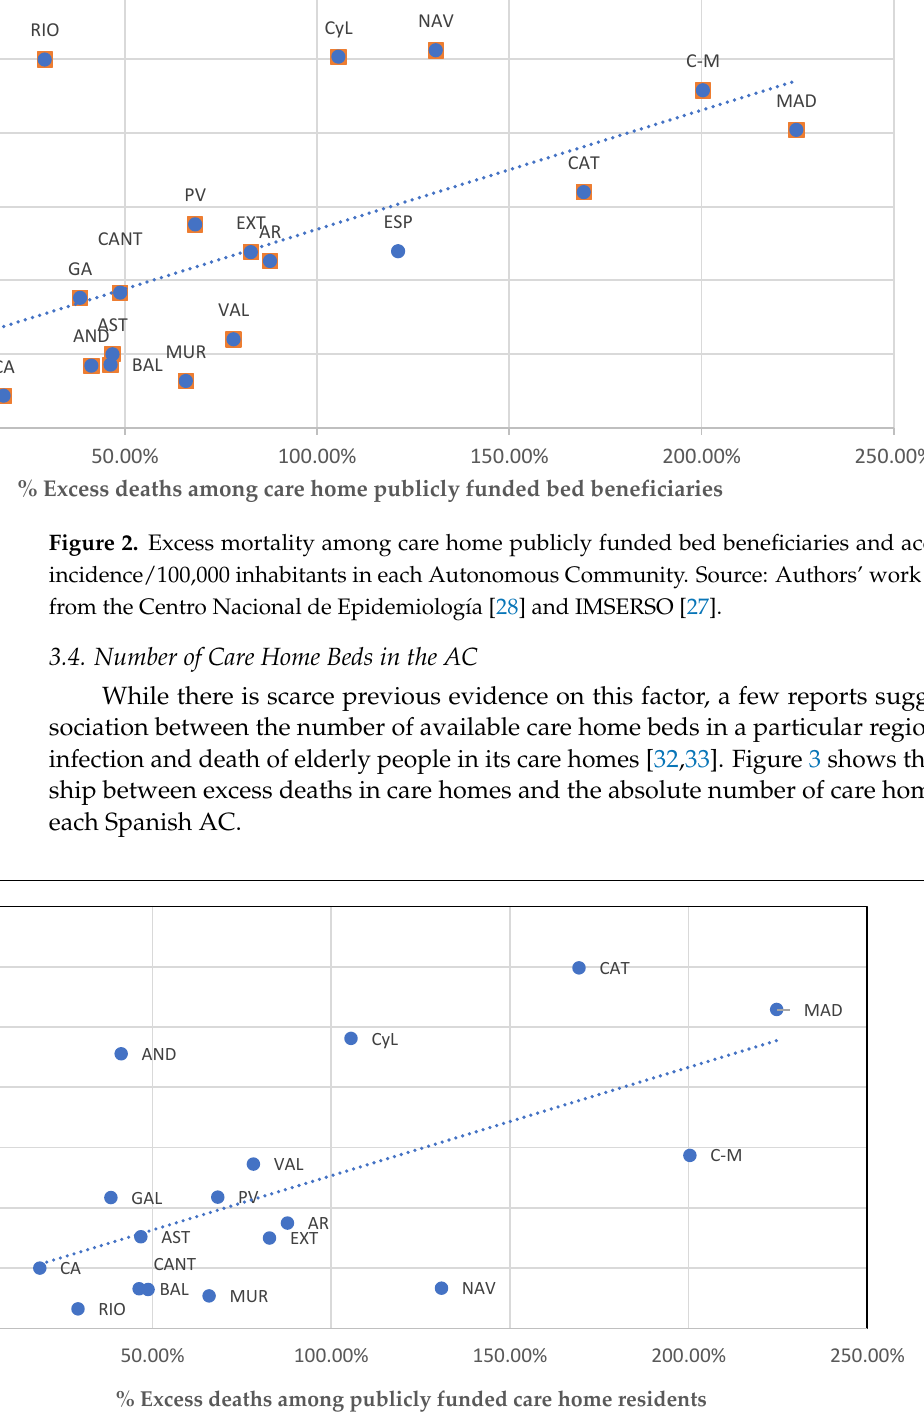
Figure 3. Excess deaths among care home publicly funded bed beneficiaries and number of beds in each AC. Source: Authors’ work using Spanish central government and AC administration